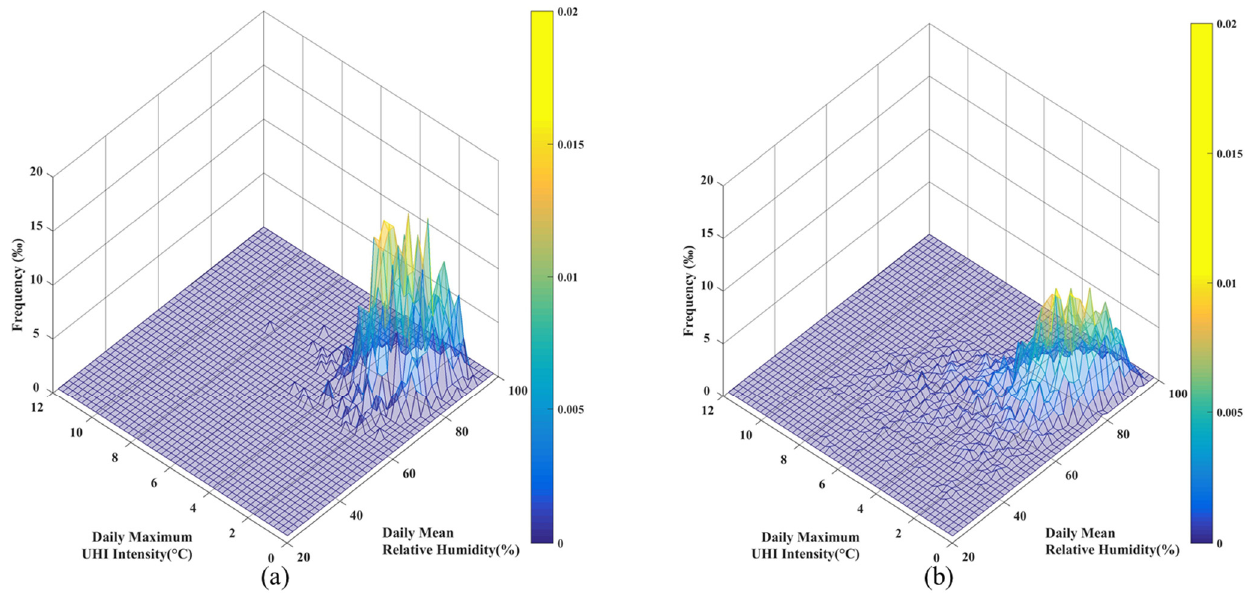
Figure 8. Frequency distribution of UHImax as a function of relative humidity (2002–2012, ( a ) summer, ( b ) annual).